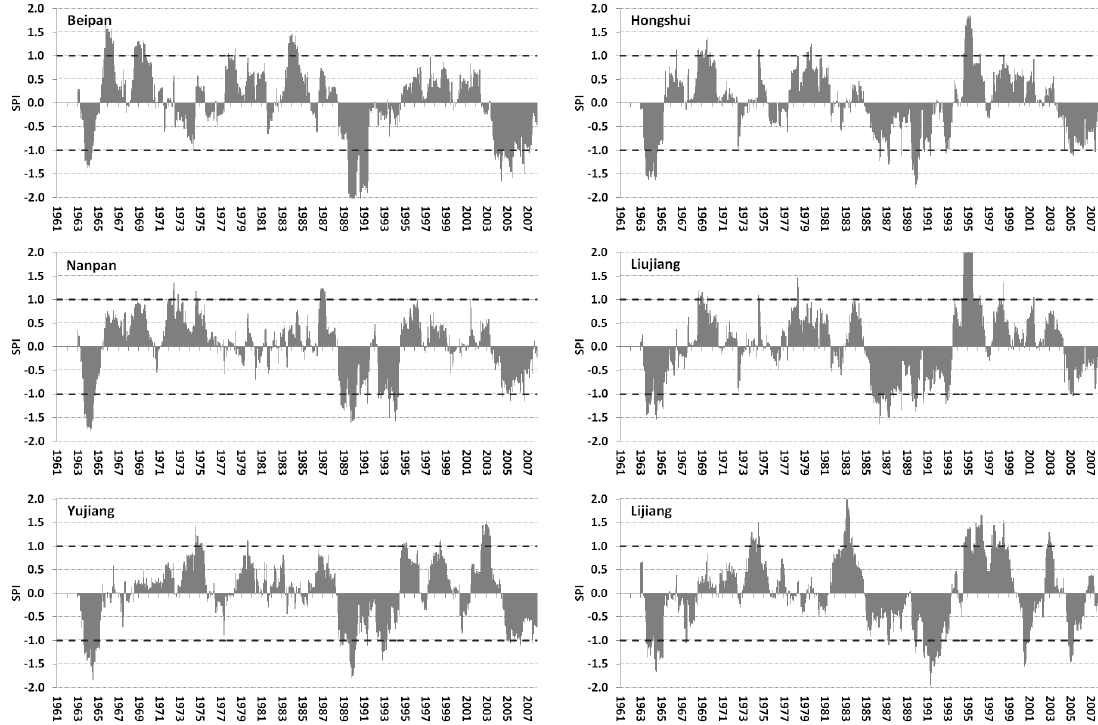
Fig. 6. SPI-24 of the six sub-basins in the Xijiang River